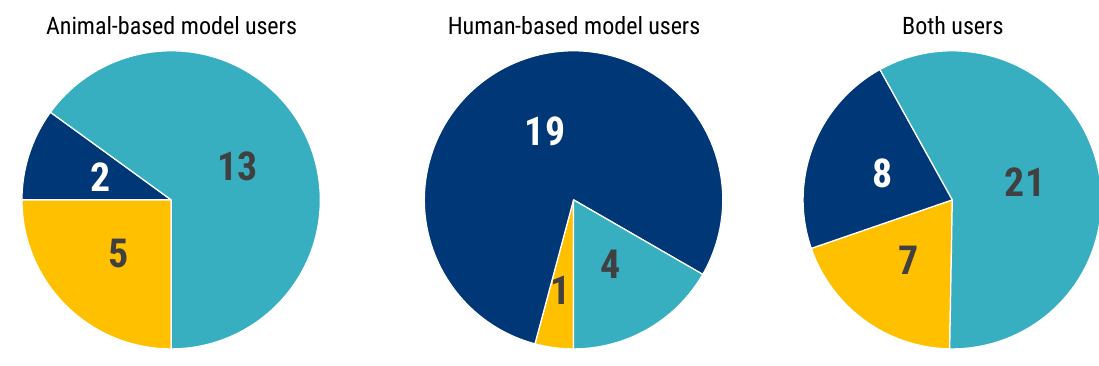
Figure 8. Participants answered the following question “In your teaching activity, are you mostly presenting human or animal experimental works ?”. The pie charts show the number of respondents answering regarding their teaching of experimental work. Each pie represents the answers for each group of researchers (animal-based, human-based or both models users).